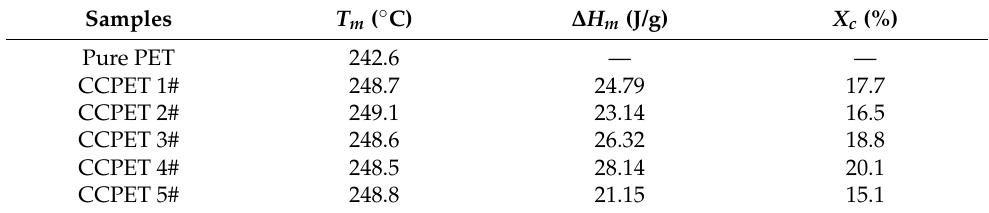
Figure 7. Melting behavior curves of pure PET, CCF/PET, and CNT/CCF/PET composites: ( a ) pure PET, (36 wt%) CCF/PET, (56 wt%) CCF/PET, ( b ) (56 wt%) CCF/PET, (0.1 wt%) CNT/CCF/PET, (1.0 wt%) CNT/CCF/PET, (2.0 wt%) CNT/CCF/PET. Table 4. Melting temperatures, melting enthalpy and relative crystallinity of pure PET, CCF/PET, and CNT/CCF/PET